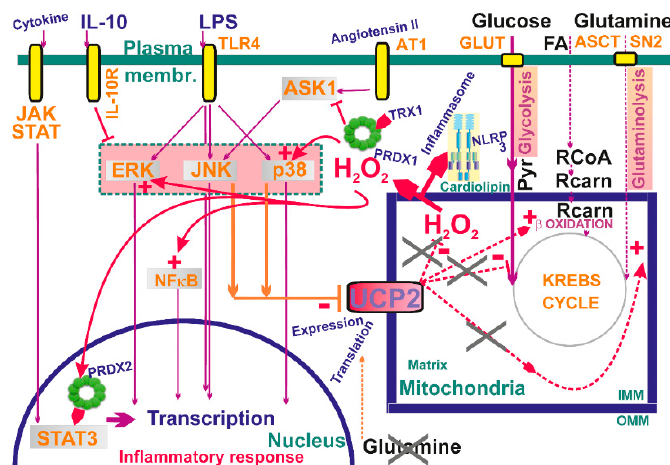
Figure 6. Examples of mitochondrial signaling upon activation of different kinases — schematic overview examples of established participation of mitochondria-generated H 2 O 2 in signaling cascades. Also, a role of inhibition of UCP2 is outlined, resulting in elevation of mitochondrial superoxide generation and hence elevated H 2 O 2 release. For a detailed explanation see Section 8 and Section 9.